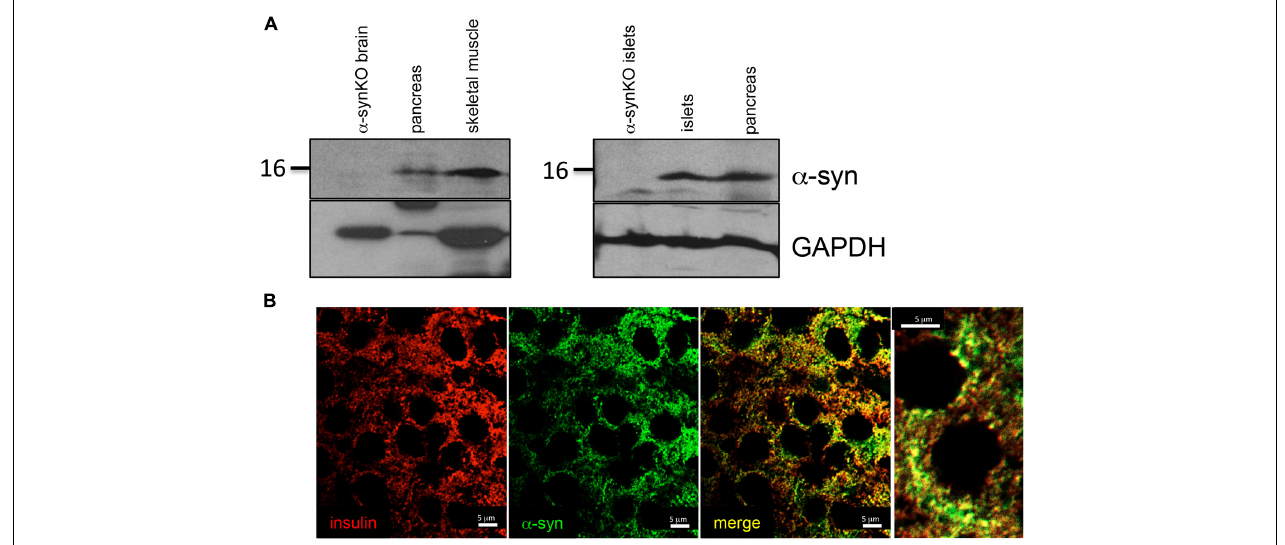
FIGURE 1 | α -syn expressed in tissues regulating glucose homeostasis. (A) Western blot analysis of α -syn and GAPDH in mouse pancreas ( n = 1), skeletal muscle ( n = 1) and pancreatic islets ( n = 2) and (B) immunostaining for insulin ( red ) and α -syn ( green ) in mouse pancreatic